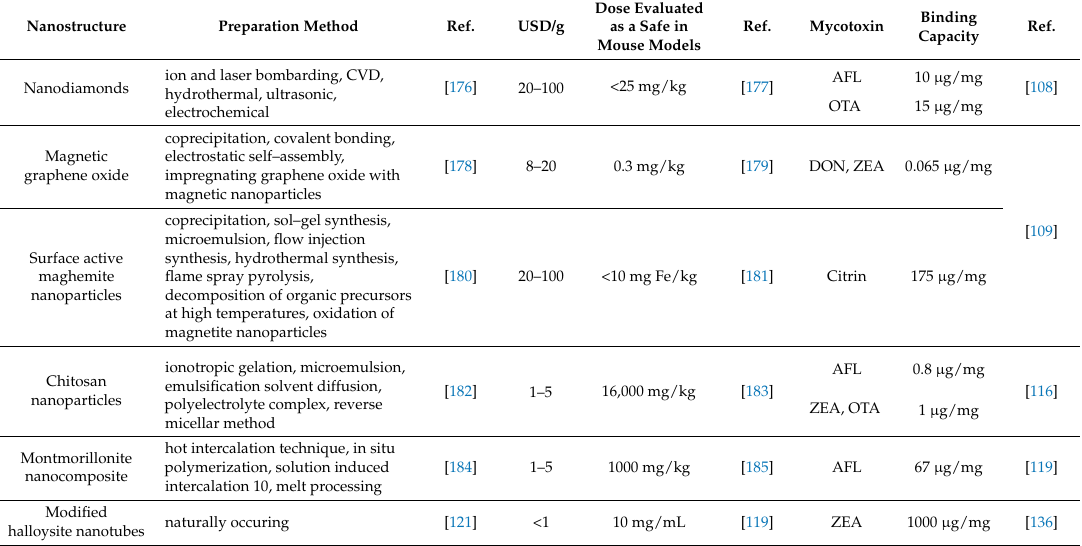
Table 3. Binding capacity and dose evaluated as safe in mouse models for selected mycotoxin